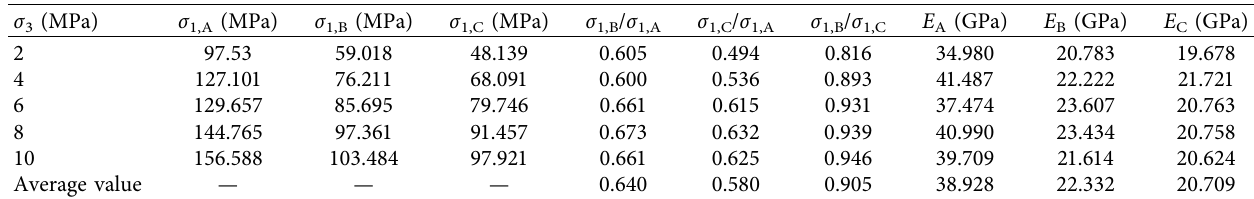
Table 2: Comparison of triaxial compressive strength and elastic modulus of the three groups of samples.